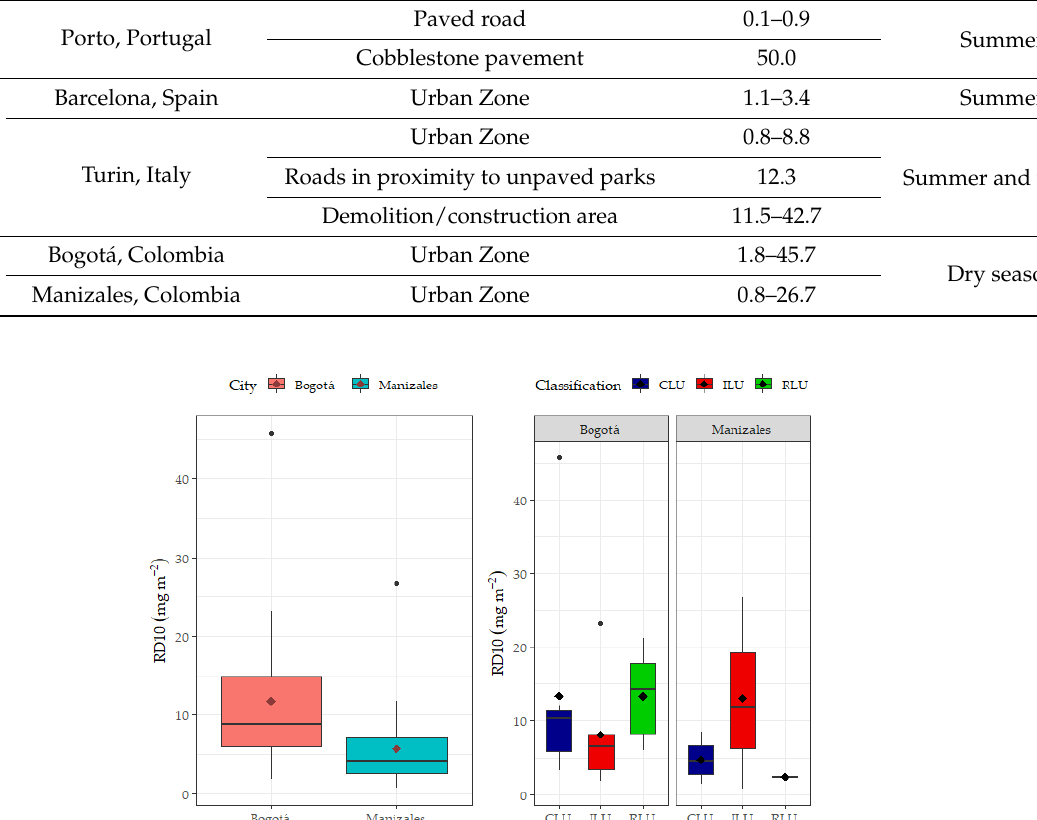
Figure 3. Spatial distribution of road dust loads in Bogotá. Figure 4. Spatial distribution of road dust loads in Manizales.